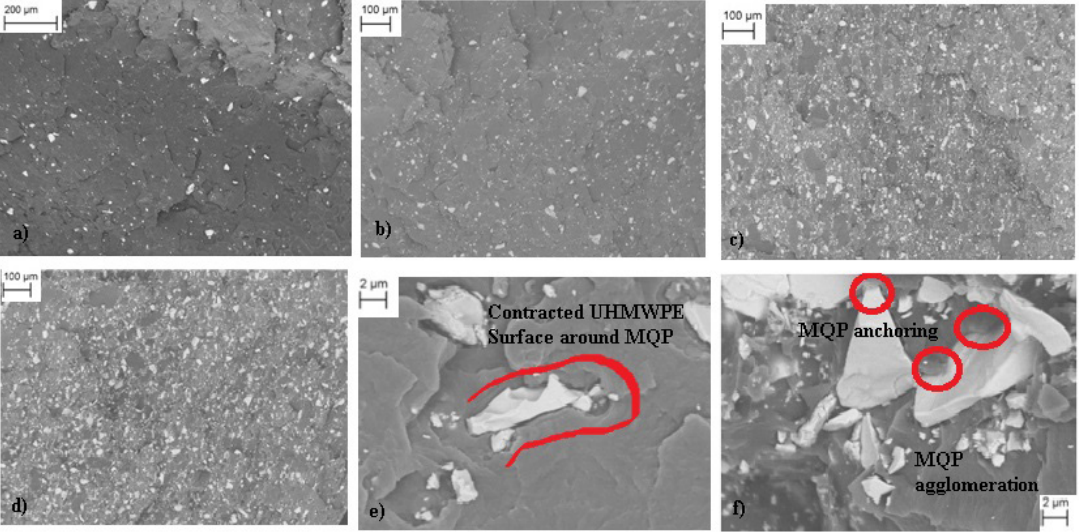
Figure 3. SEM micrographs of the composites samples: a) 0.01 MQP; b) 0.02 MQP; c) 0.06 MQP; d) 0.15 MQP; and e), f) details of the 0.02 and 0.15 MQP composites.